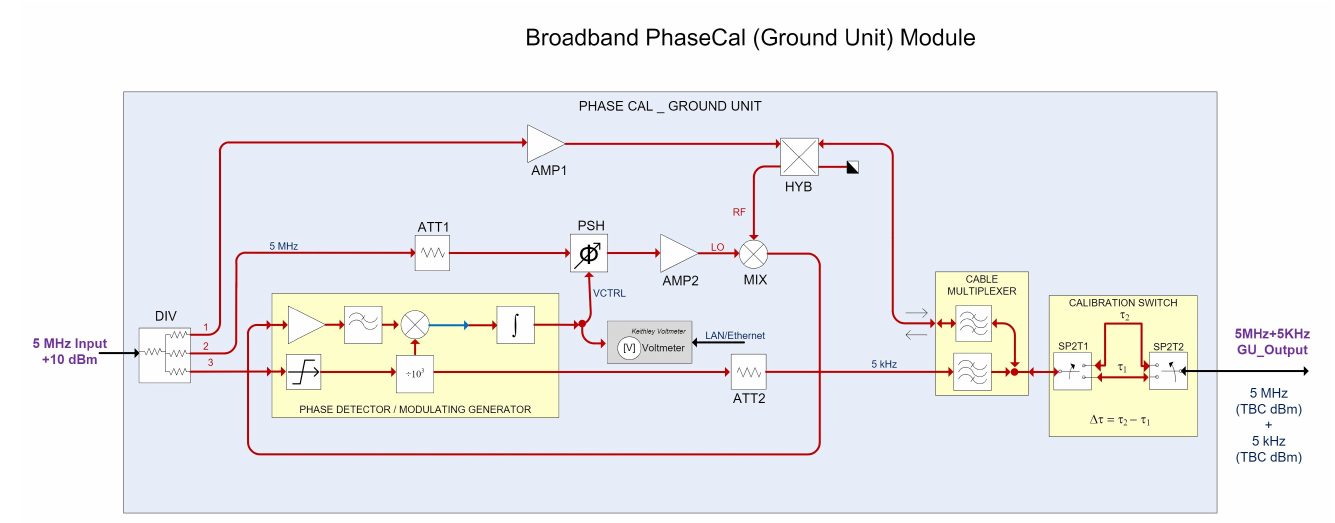
Figure 4. Block diagram of the new GU designed in Yebes